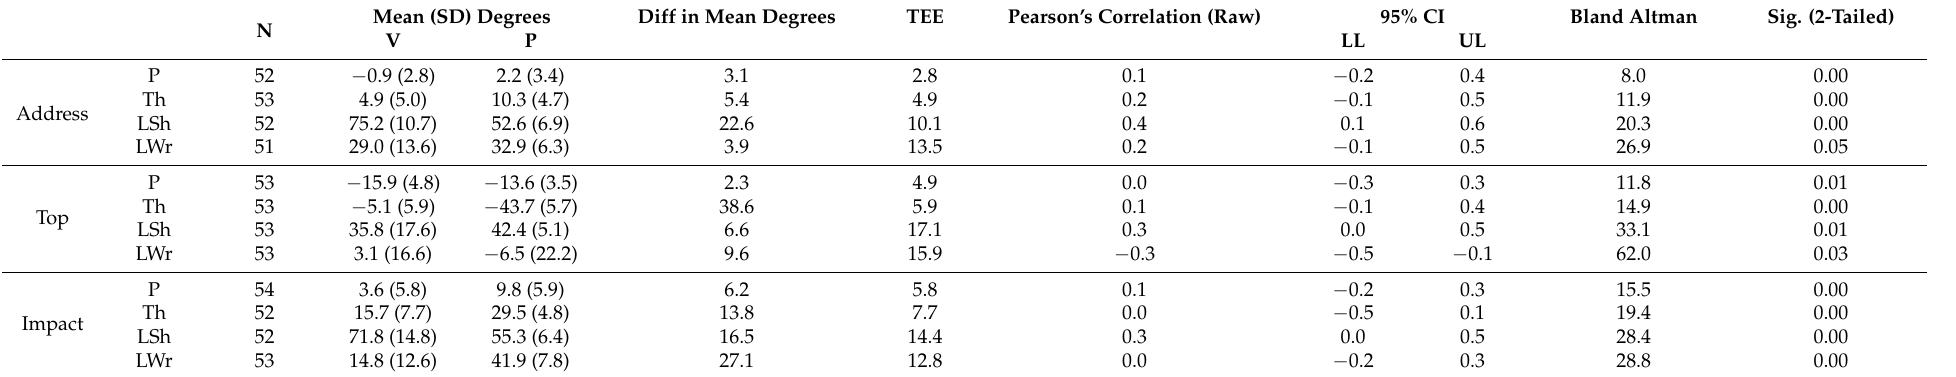
Table 6. Comparison between Polhemus Liberty (practical) and VICON Nexus (criterion) in the anterior/posterior